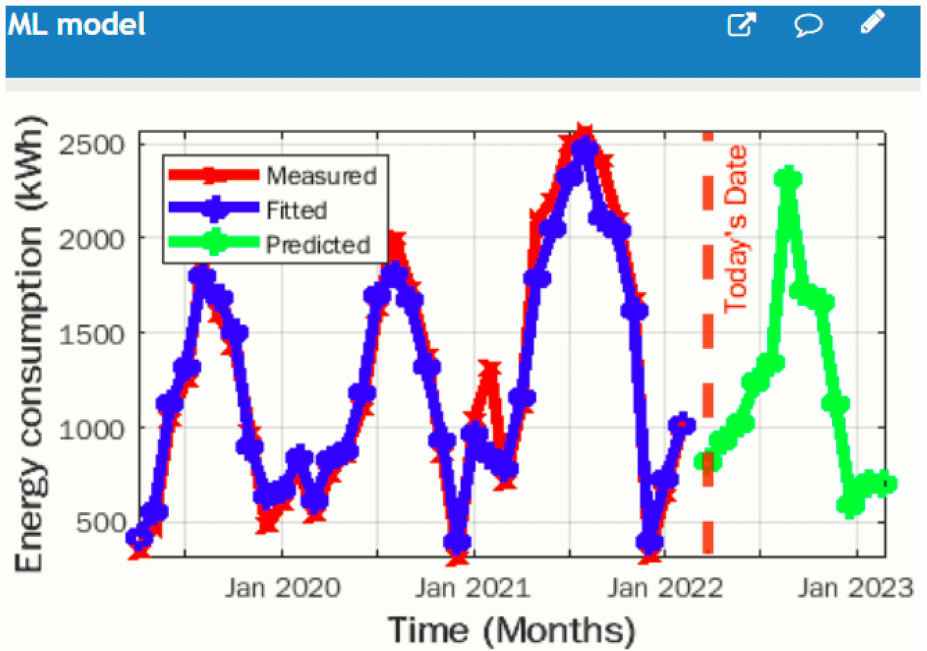
Figure 10. Graph of deployed DPB load forecasting model on